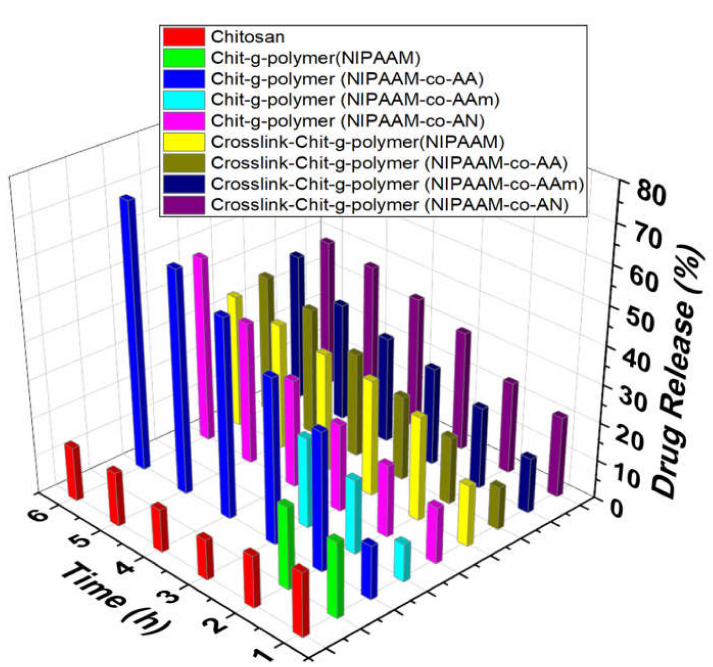
Figure 7. Drug Release performance of Grafted Copolymers and Crosslinked-graft Copolymers of NIPAAM and Binary Comonomers onto Chitosan. Polymeric taster = 25.00 mg, Concentration of DS solution for the drug-laden = 100.00 µ g/mL, amount of buffer solution = 10.00 mL, pH of the solution = 2.2.